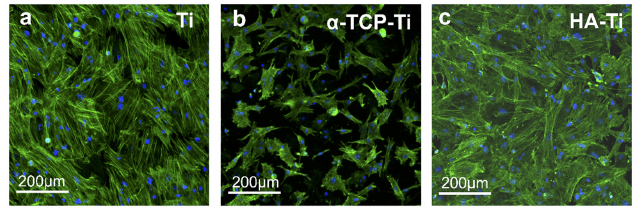
Figure 11. Morphological analysis of rat bone marrow mesenchymal stem cells attached to ( a ) Ti, ( b ) α -TCP-Ti, and ( c ) HA-Ti discs after 24 h of culture. Actin filaments (green) were labeled with Alexa Fluor ® 488, and nuclei (blue) were stained with 4 ′ ,6-diamidino-2-phenylindole. The morphology of the cells after 24 h of culture was examined via SEM. The cells attached and spread close to the surface of the specimens (Figure 12). Compared with those on Ti (Figure 12a) and blast-Ti (Figure 12b), the cells on HA-Ti (Figure 12c) had numerous cytoplasmic extensions and filopodia, and spread along the uneven surface of the sample. Higher magnification images of a specific area of the HA-Ti sample (marked by the orange rectangular area in Figure 12c) clearly revealed the morphology and num- ber of cellular pseudopods (marked by red arrows).